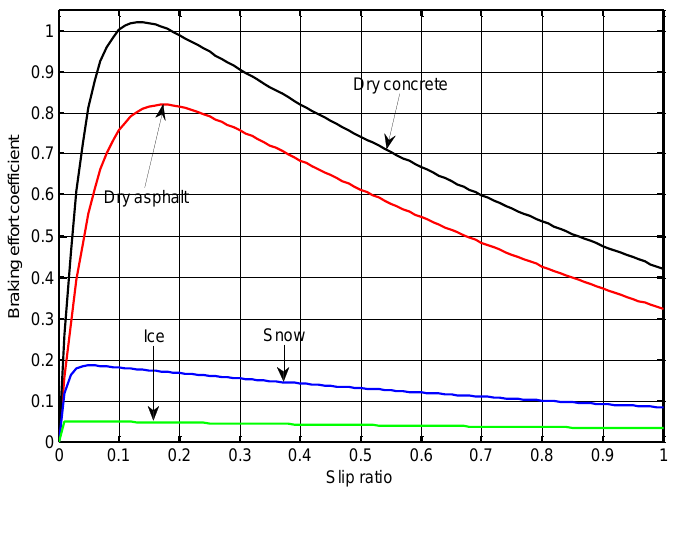
Figure 2. Slip-friction curves for different road conditions.